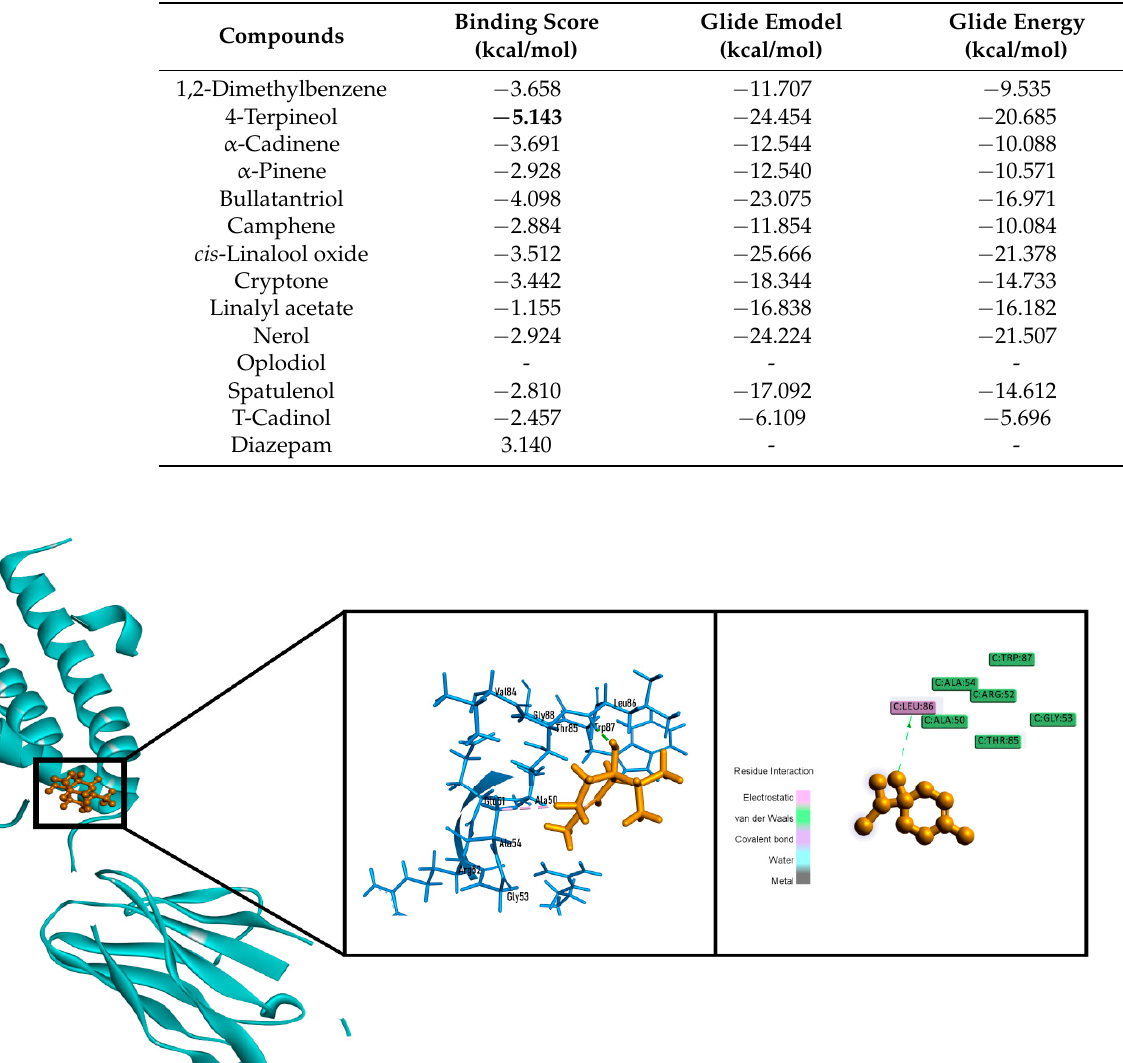
Table 4. Docking score of the phytochemical compounds of essential oil in leaves of H. aromatica with potassium channel receptor (PDB: 4UUJ) for anxiolytic activity (Bold indicates lower docking score).